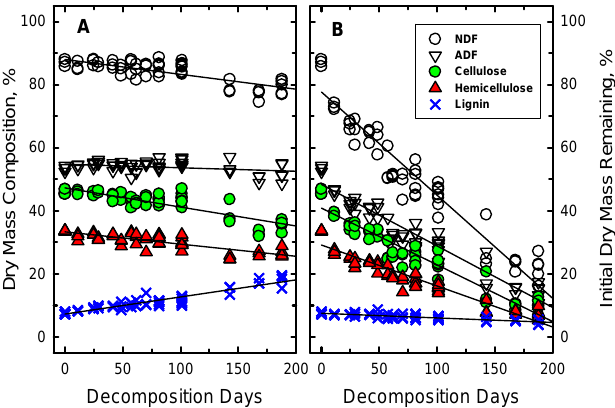
Changes in the (a) concentrations and (b) initial mass of the structural components of wheat straw as a function of decomposition days (DD). The root mean square error (RSME) of the regression line for each component, except NDF, is smaller than the symbol size. For NDF, the RMSE is 1.3 times the symbol